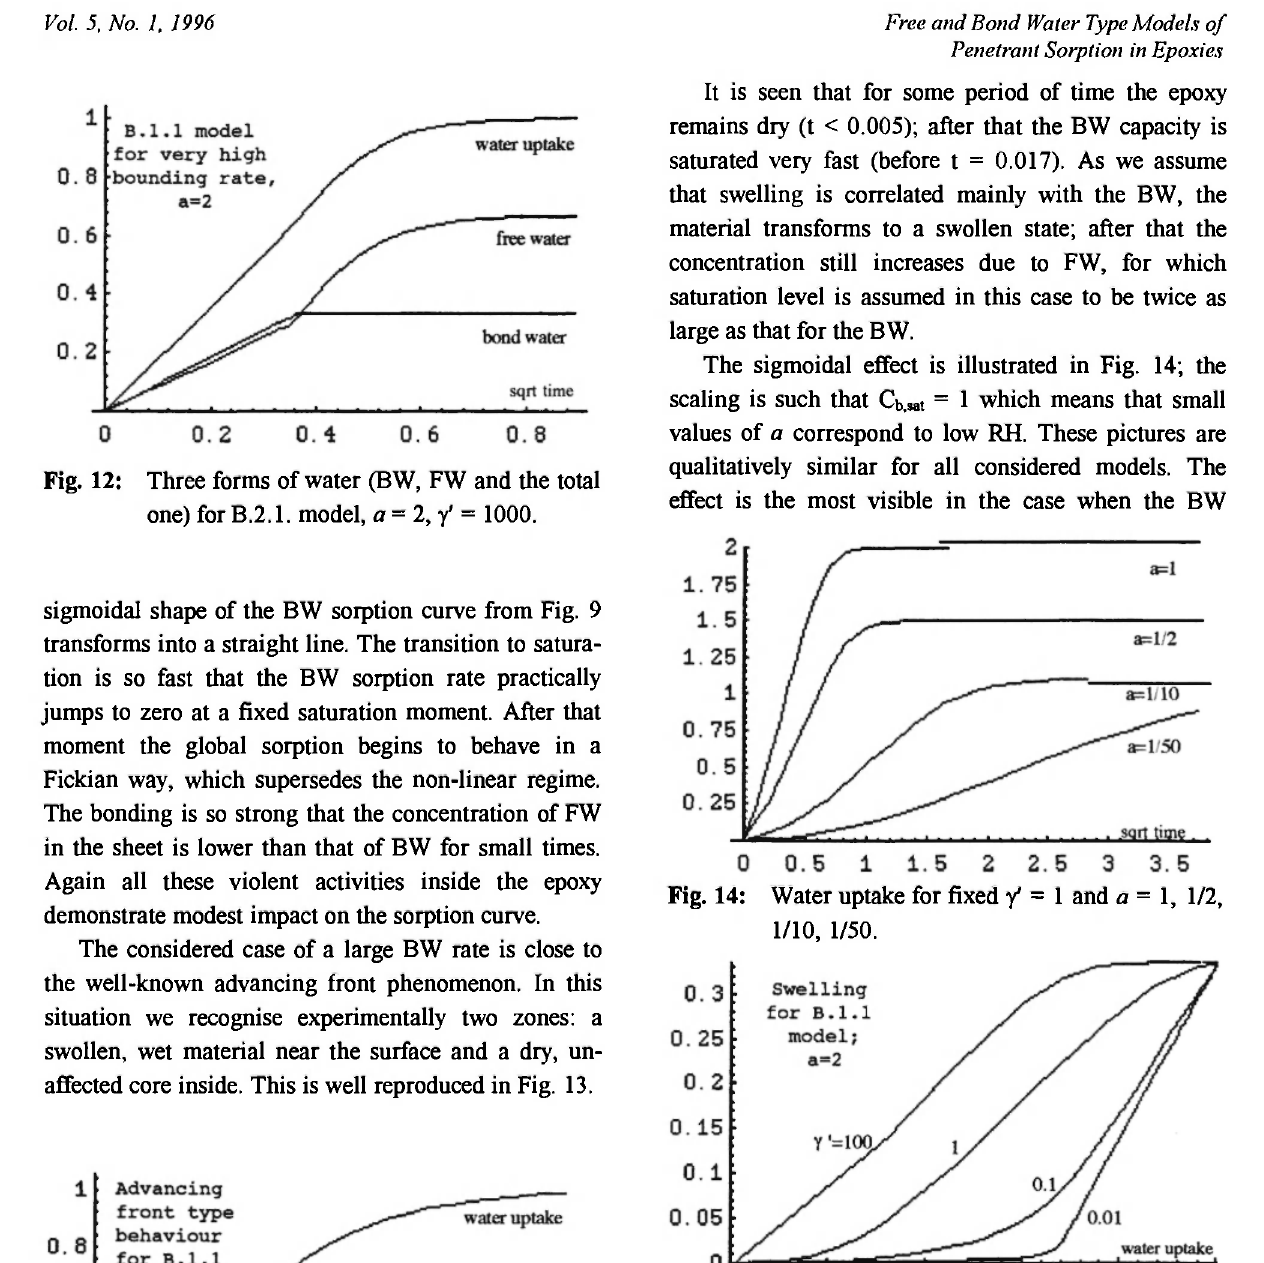
Fig. 13: The three water concentrations at the middle point z' = 0.5 (same values of parameters as in Fig. 12).